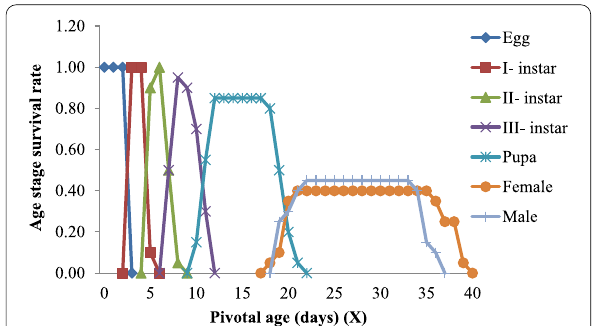
Fig. 2 Age-specific survival rate ( s xj ) of S. pyrastri on B. brassicae